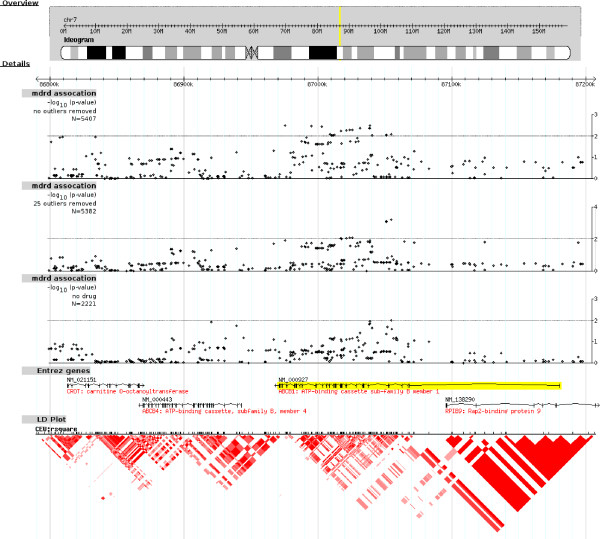
Genetic associations with GFR, in the region around the ABCB1 gene. Associations are shown for both directly genotyped and imputed SNPs. The bottom panel shows the pattern of linkage disequilibrium in the HapMap CEU panel. We imputed genotypes for all HapMap SNPs in the region around ABCB1. In this region, linkage disequilibrium patterns in CoLaus were similar to the ones observed in HapMap, although they were resolved at a coarser scale due to lower SNP density. Since it was not computationally feasible to combine imputation and permutation approaches, we plot P values calculated assuming the normal linear model. For directly genotyped SNPs, the differences between calculated and permutation P values were small. The top three hits (and P values) are rs17327624 (0.0006), rs4148733 (0.0008) and rs17327442 (0.0008). The former two were directly genotyped and are in strong LD (D' = 0.96 in CoLaus and 1.00 in HapMap CEU, r2 = 0.63 and 0.72 respectively), and the imputed SNP rs17327442 is in perfect LD with rs17327624 in HapMap CEU.